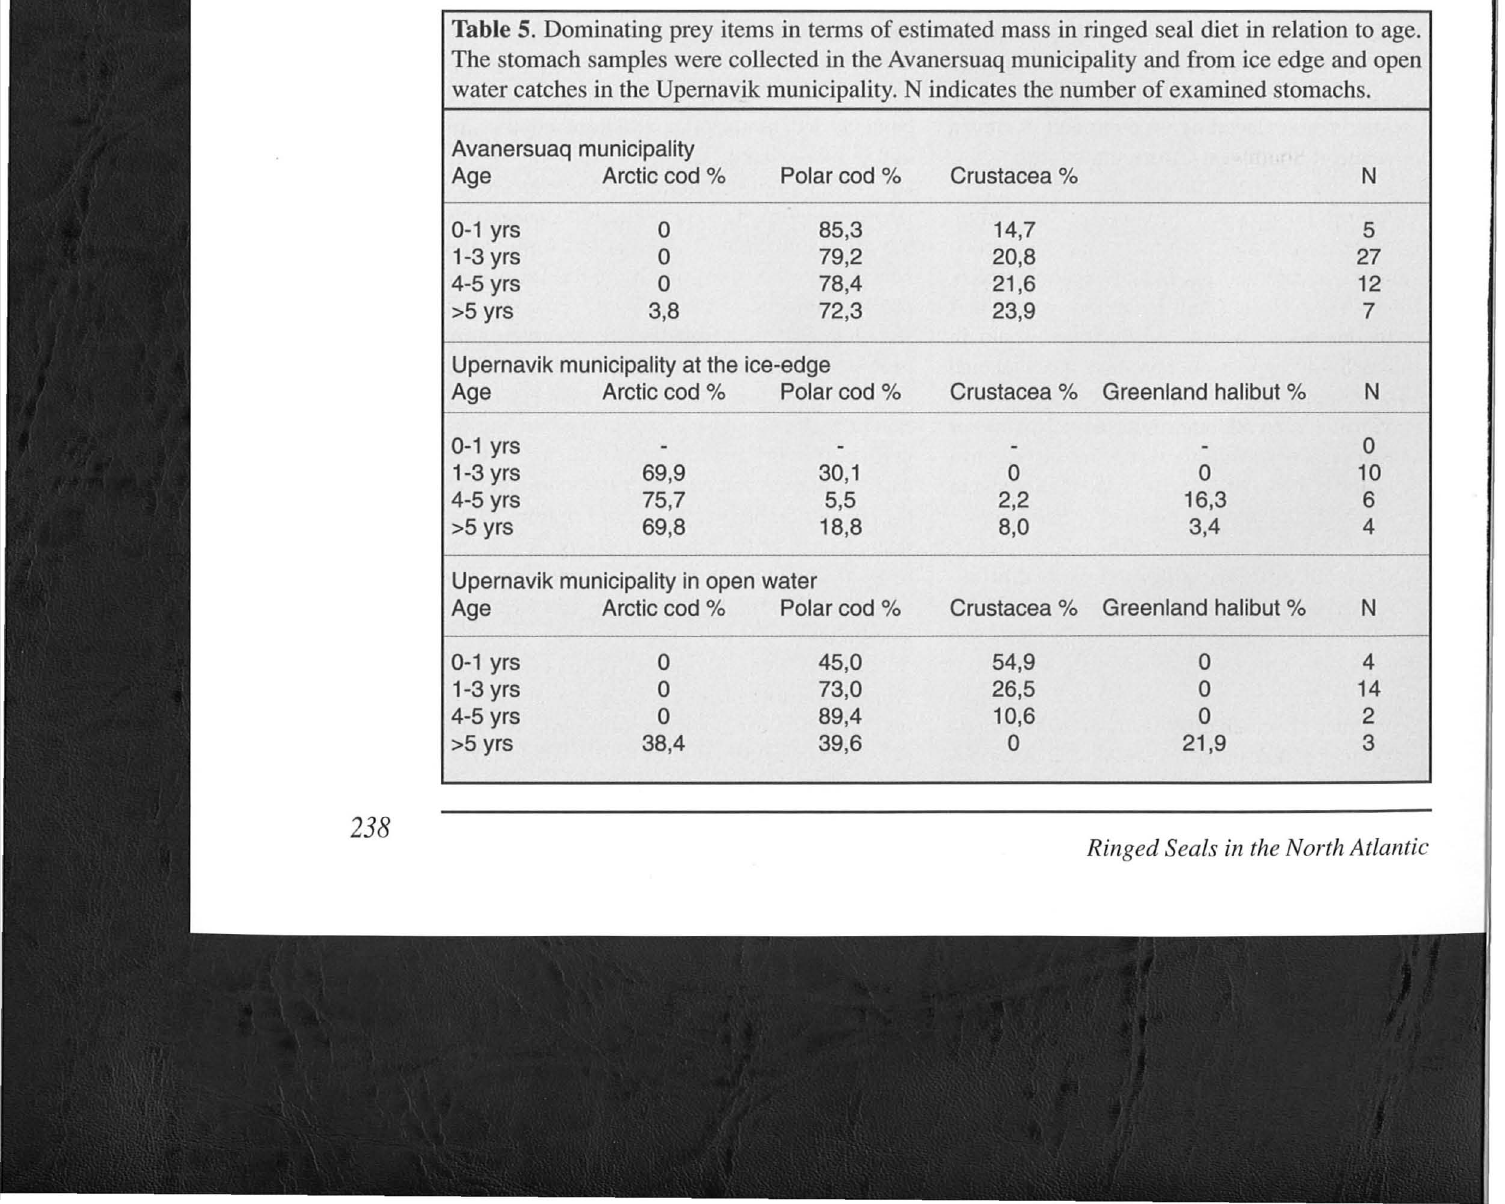
Table S. Dominating prey items in terms of estimated mass in ringed seal diet in relation to age. The stomach samples were collected in the Avanersuaq municipality and from ice edge and open water catches in the Upernavik municipality. N indicates the number of examined